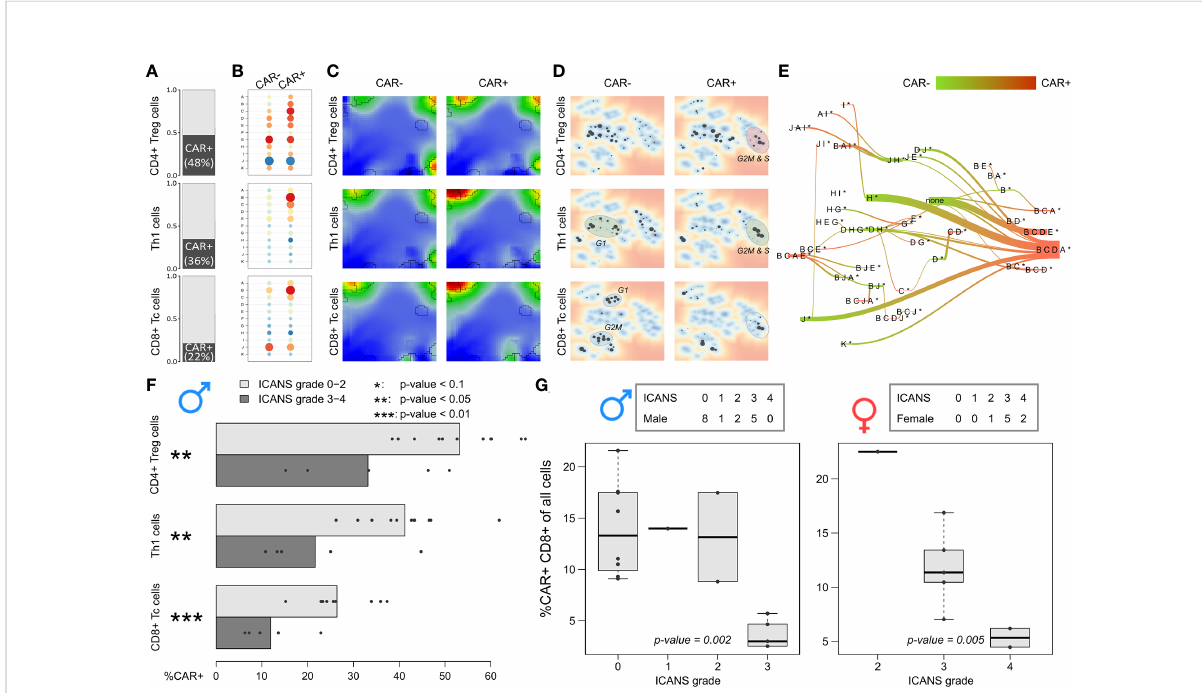
FIGURE 8 Expression patterns and relative abundance of CAR-positive and – negative T cells: (A) Relative amount of CAR+ cells in the subpopulations, respectively. (B) Module expression values grouped by subpopulations and CAR status. Blue dots represent under-expressed modules, red dots over-expressed ones. (C) Corresponding expression portraits. (D) Maps of enriched PATs in CAR-positive and – negative subpopulations. (E) PAT fl ow between CAR-positive and – negative cells. (F) Fraction of CAR-positive cells in each male patient grouped by T cell subpopulation. Bar lengths represent the mean percentage for the two ICANS groups, the dots represent the individual patients. p-values were computed using Wilcoxon rank-sum test. (G) Relative amount of CAR-positive CD8+ T cells in male (left frame) and female patients (right frame) grouped by ICANS grade. p-values were derived from linear regression